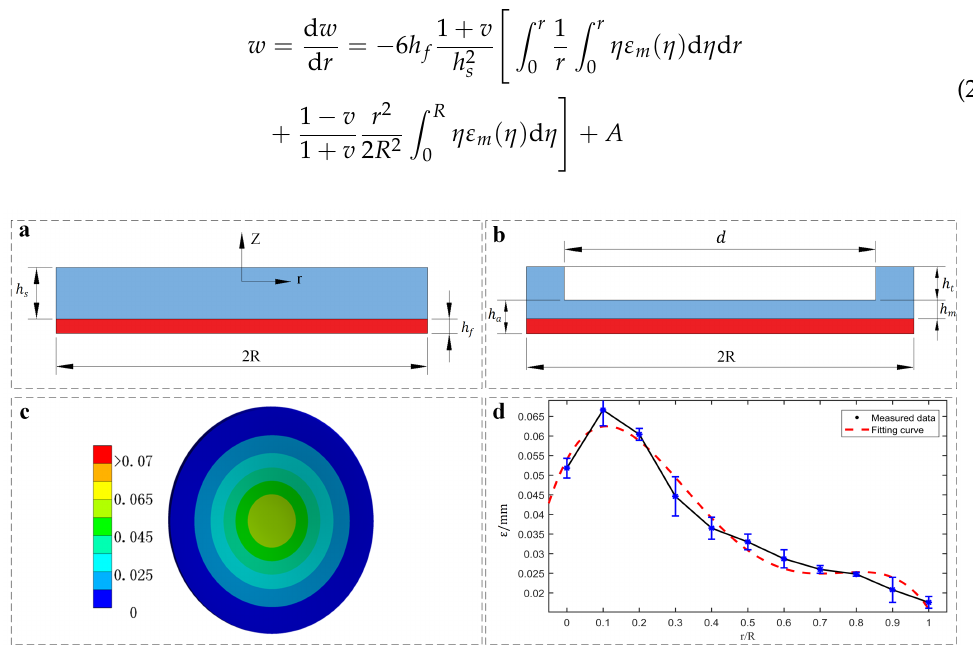
Figure 3. ( a ) Schematic of thin film (red)/substrate (blue) system with misfit strain for doming deformation; ( b ) schematic of the proposed bilayer doming model with cylindrical groove; ( c ) The finite element analysis result of the actuator upon 1 kg payload shows the radial strain; ( d ) the measured strain of the actuator along the radial